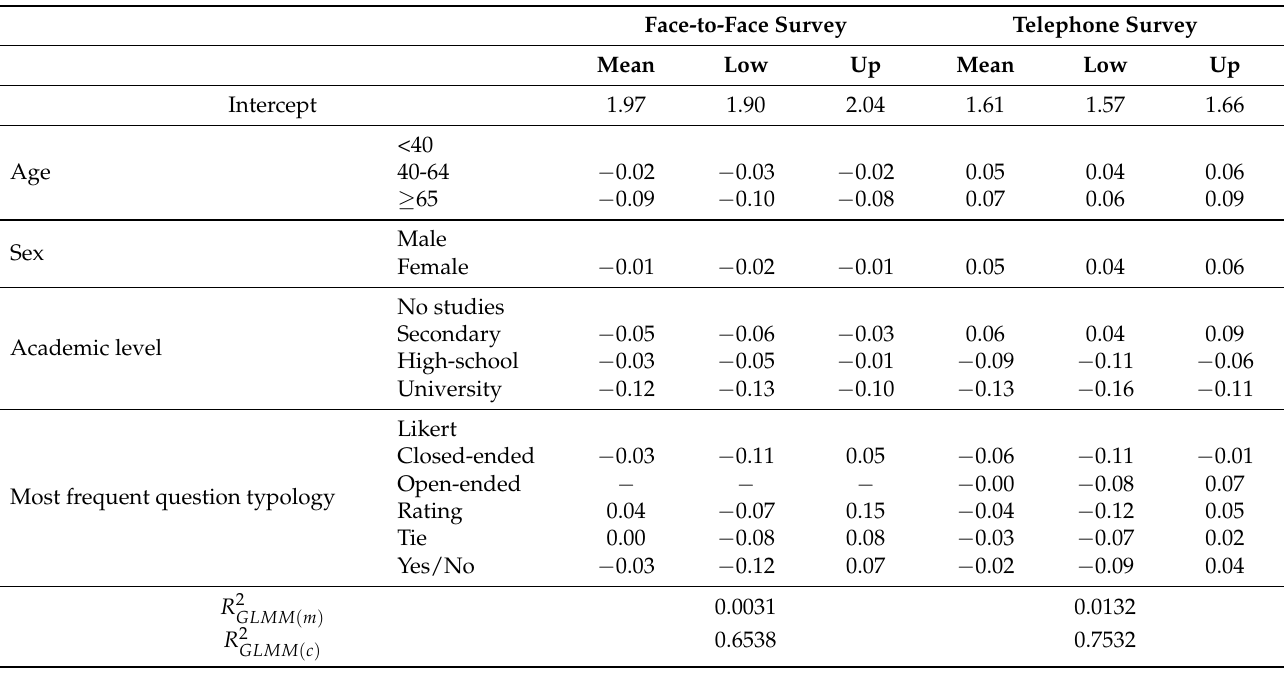
Table 5. Fixed-effect estimates corresponding to the modeling of the longstring index, following Equation (5), in terms of the mean of the posterior distribution of each parameter involved. The lower (Low) and upper (Up) bounds of the 95% credibility interval associated with each estimate are also provided.